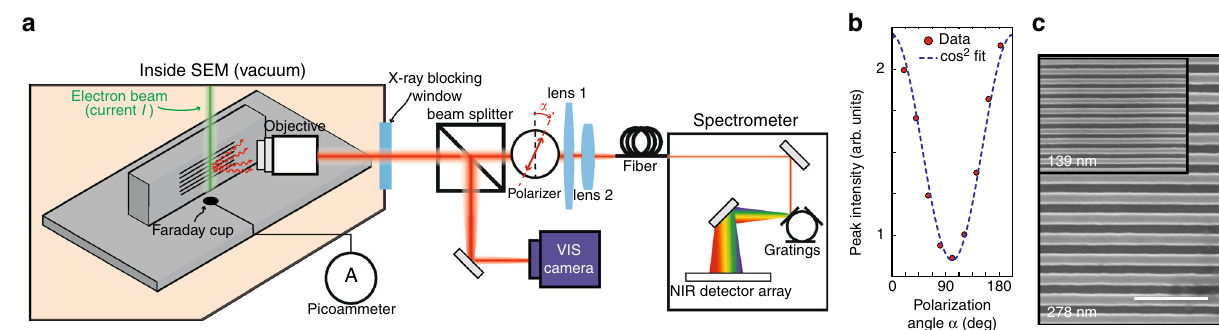
Fig. 3 Spectrally, spatially, and polarization-resolved modi fi ed-SEM cathodoluminescence measurement setup. a A modi fi ed SEM generates an electron beam impinging on a nanograting at a grazing angle. A Faraday cup, mounted on the sample holder, is used to record the electron beam current I . A microscope objective collects and couples out the radiation induced by free electrons to a set of free space optics. b Peak intensity as a function of the polarization angle. α ¼ 0 corresponds to the direction of electron beam propagation. The dashed line shows an af fi ne fi t in cos 2 α . c Scanning-electron micrographs of 278 and 139 nm (inset) silicon nanogratings. Scale bar is 1 µ